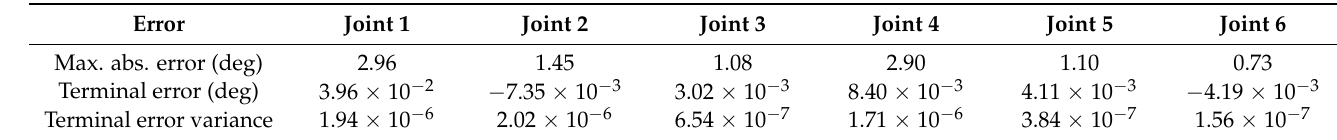
Table 5. Mean values of maximum absolute tracking errors and terminal errors with their variances of all